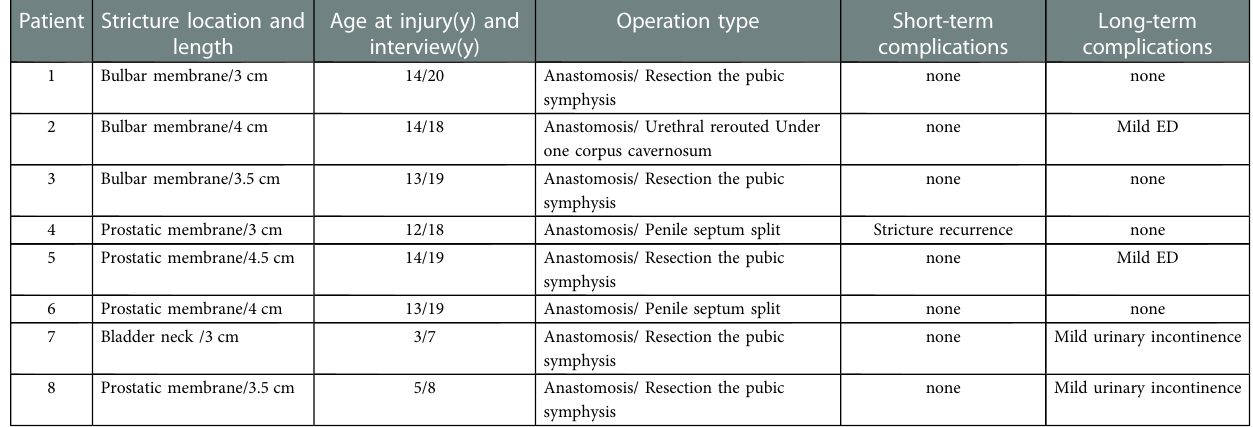
TABLE 2 The outcome of follow up for the